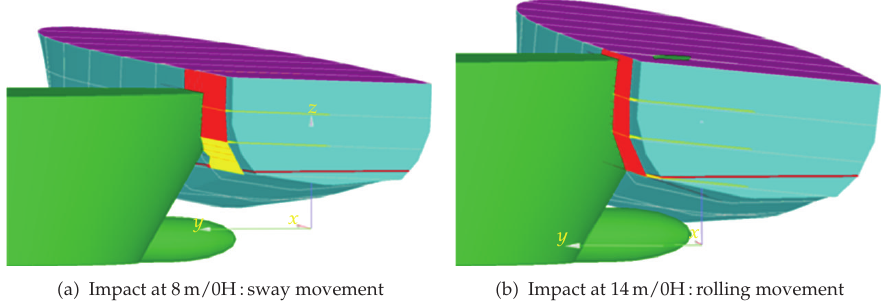
Figure 19: Vertical impact sensitivity: resulting struck ship sway and rolling